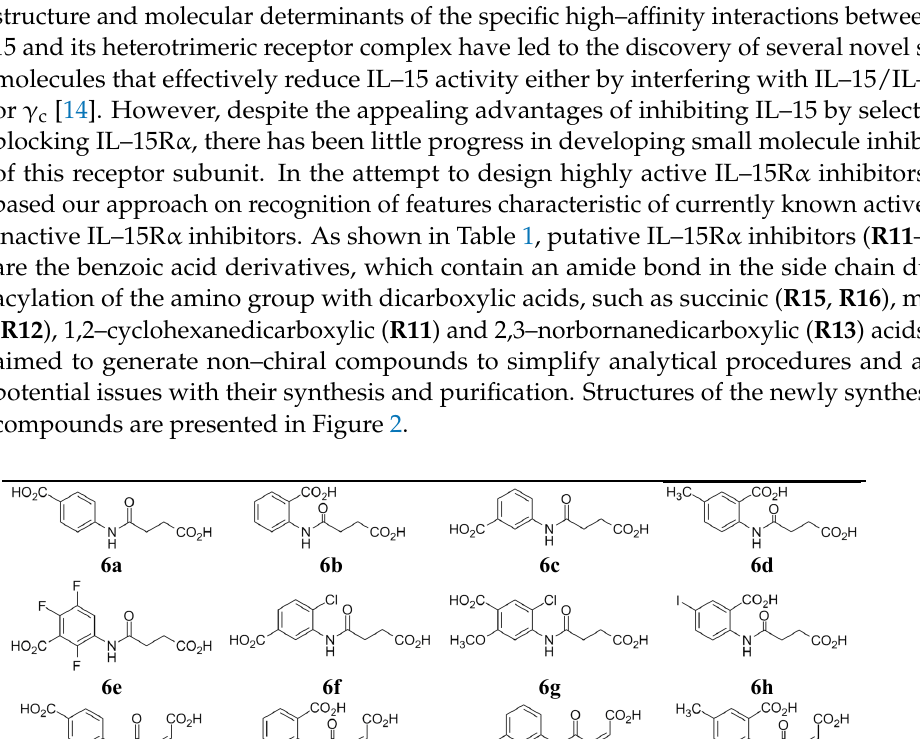
Table 2. Free energy of binding ( Δ G bind ) and binding constant ( K i ) estimated for the evaluated com- pounds.